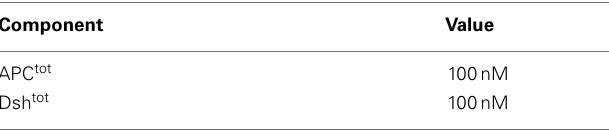
TableA2 |Total protein concentrations of proteins obeying a conservation relation.